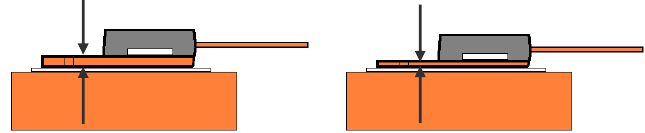
Figure 16. TO-220 package on cold plate: double gauge and single gauge.